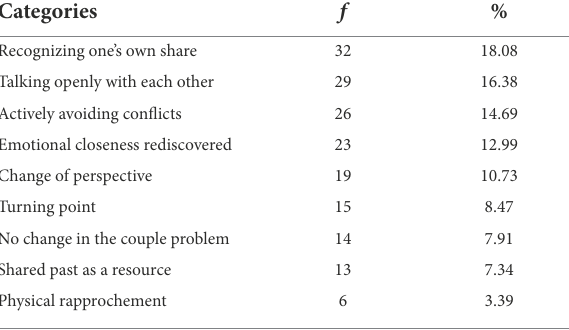
TABLE 2 Categories for which changes were reported during the consultation